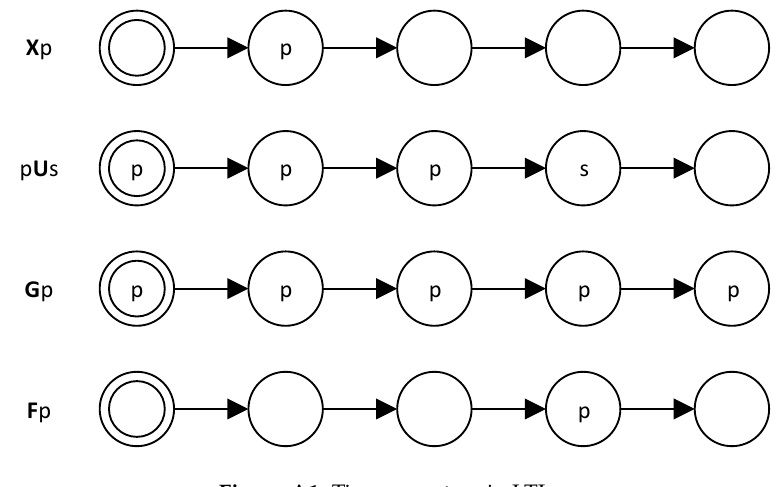
Figure A1. Time operators in